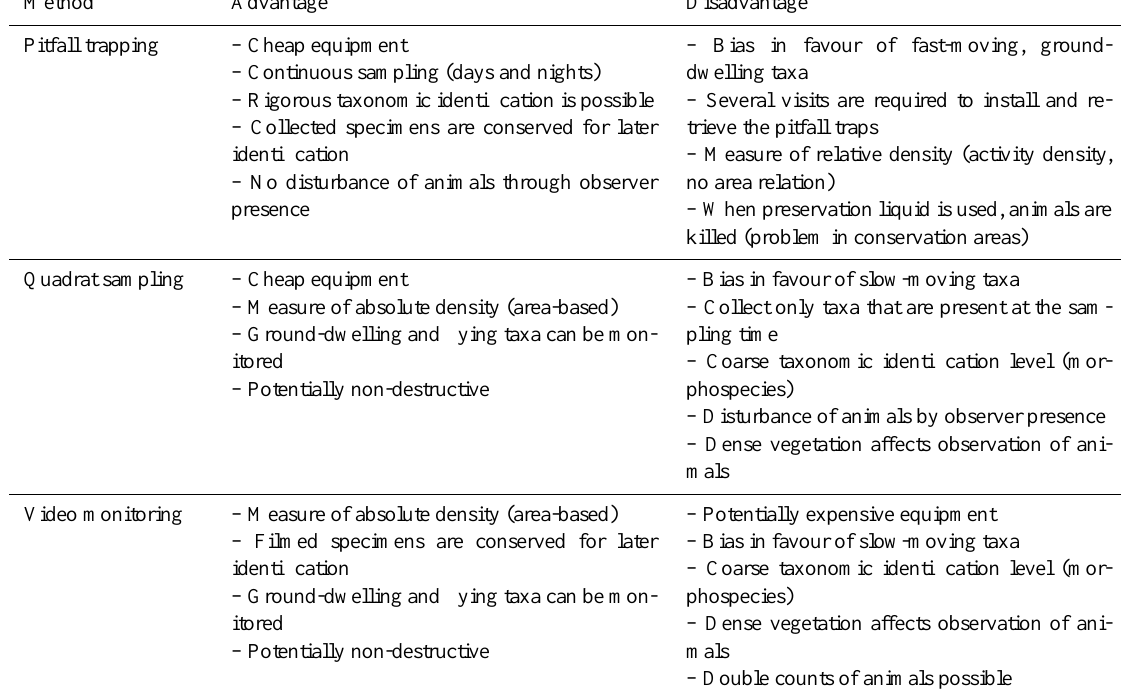
Table 4. Advantages and disadvantages of using pitfall trap and quadrat samples to collect terrestrial invertebrates in dry